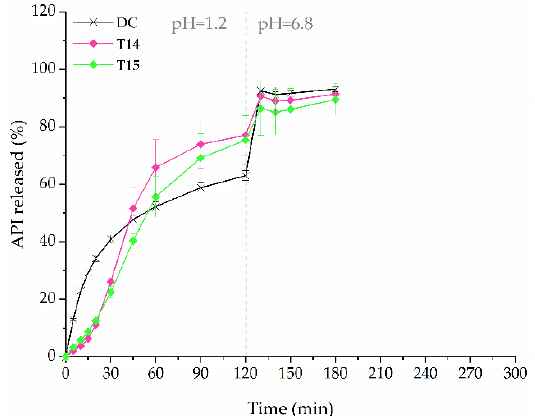
Figure 13. The dissolution profiles of ketoprofen from directly compressed (DC) tablets and co- extruded 3DP formulations (dosage equal to 100 mg).